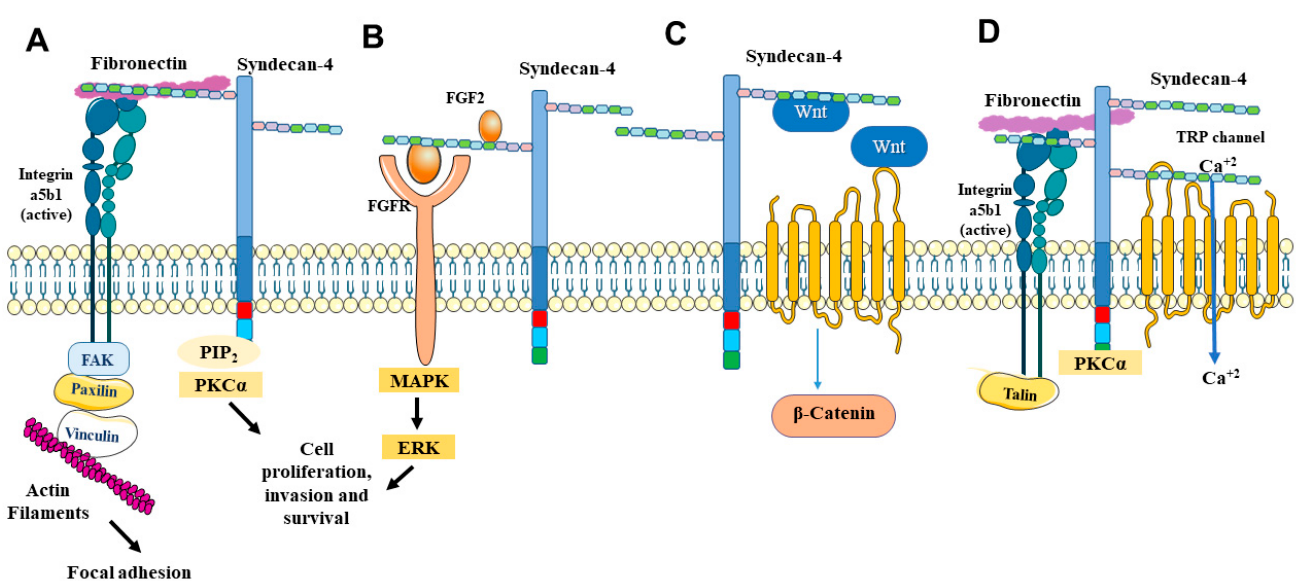
Figure 1. Overview of signaling pathways activated by syndecan-4. ( A ) Syndecan-4 and integrin signaling. ( B ) Syndecan-4 and growth factors. ( C ) Syndecan-4 and Wnt signaling. ( D ) Syndecan-4 and TRPC channels. See text for details.